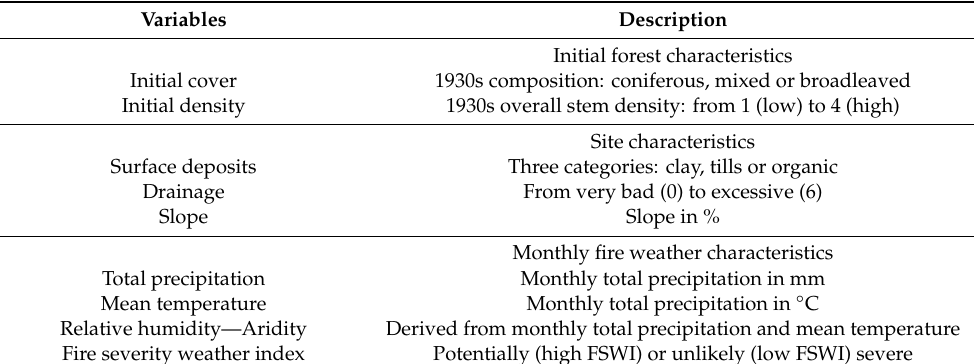
Table 1. Description of explanatory variables.